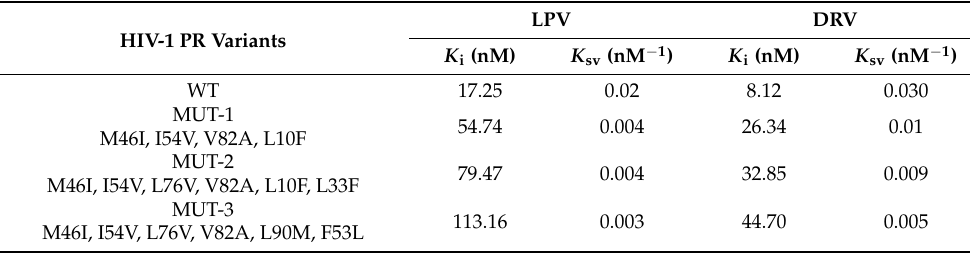
Table 2. Inhibition constant (K i ) and Stern–Volmer quenching constants ( K sv ) calculated from fluorescence quenching assay.